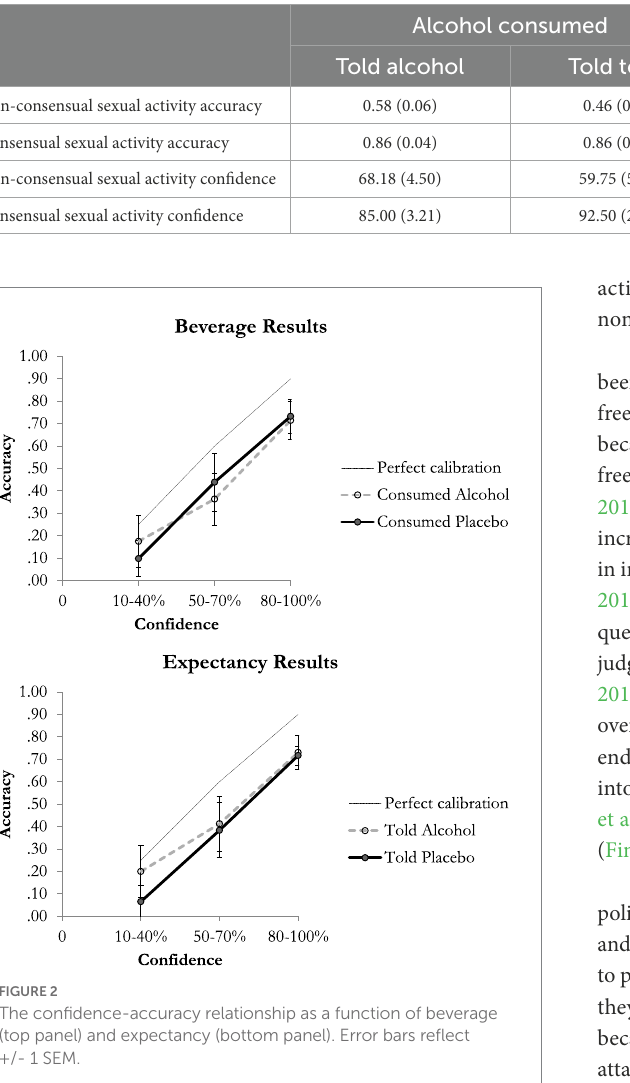
TABLE 3 Mean (SEM) for the dependent variables by beverage condition (alcohol consumed versus tonic consumed) and expectancy condition (told alcohol versus told tonic).